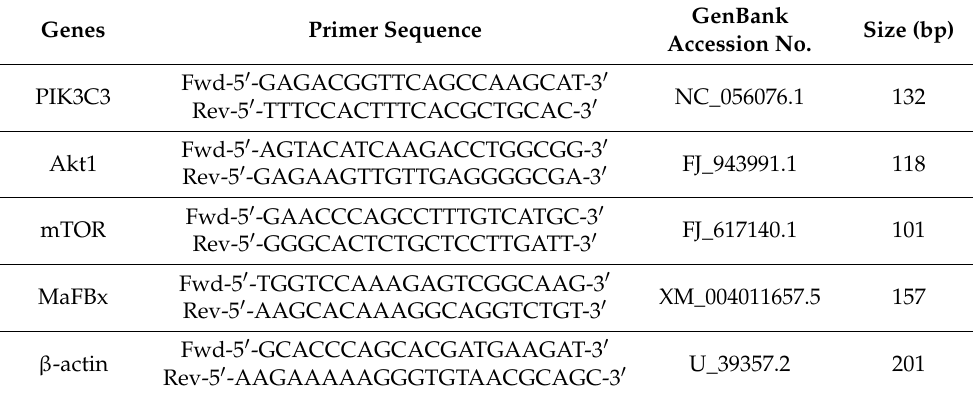
Table 2. PCR primers for real-time PCR assay. Genes Primer Sequence